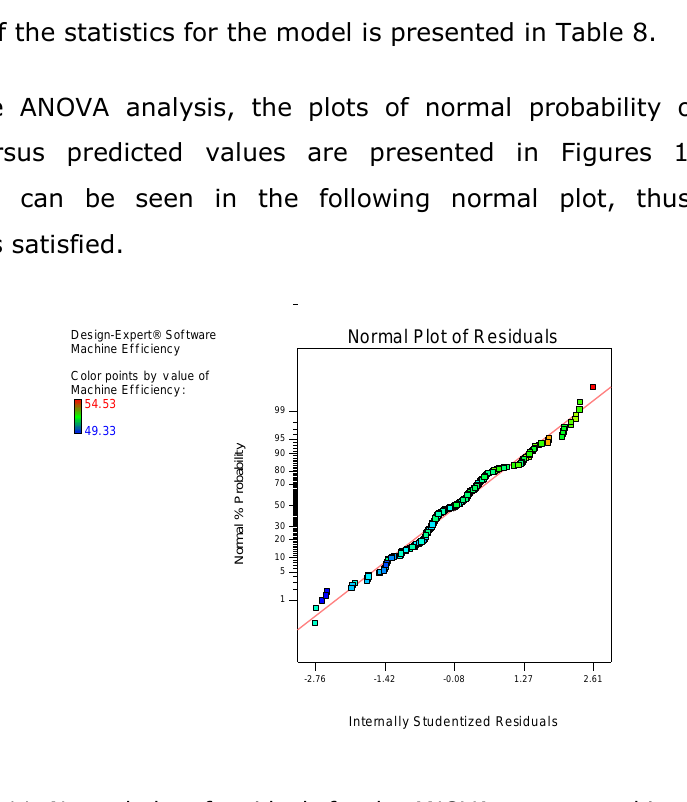
Figure 11. Normal plot of residuals for the ANOVA test on machine efficiency